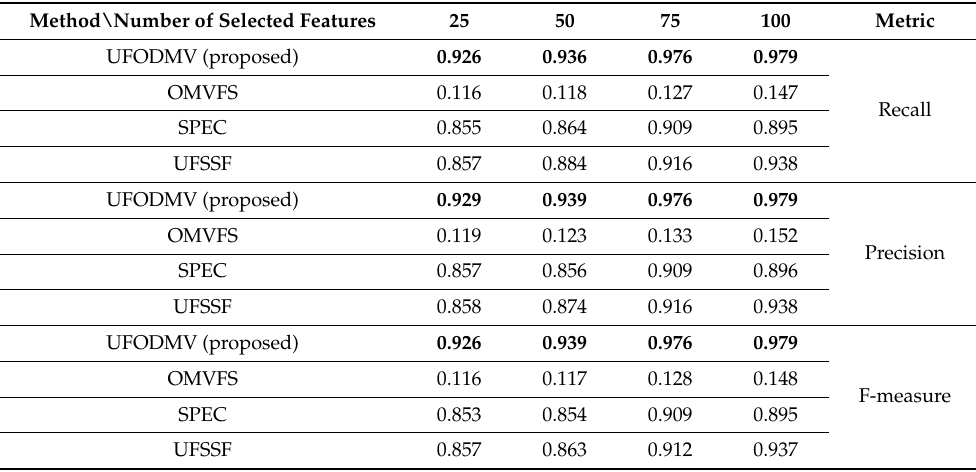
Table 4. Classification accuracy using Handwritten dataset with IB1. Method\Number of Selected